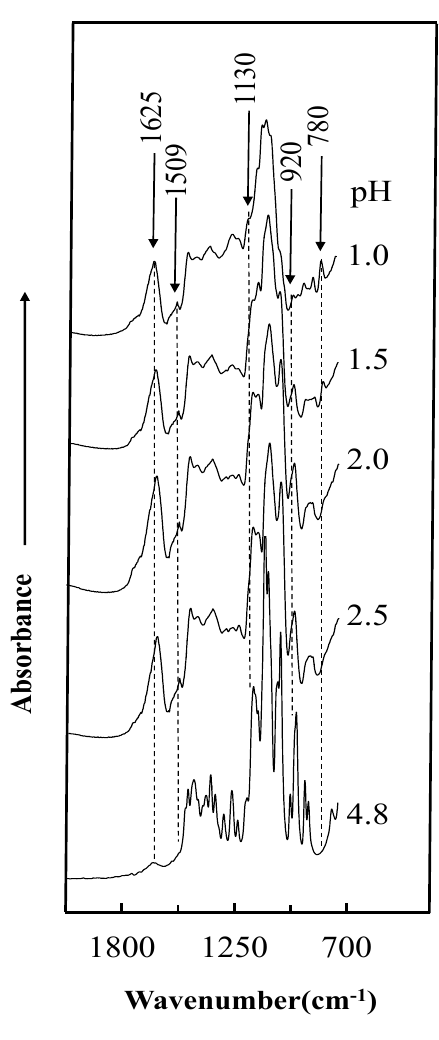
Figure 4. FT-IR spectra of uncured adhesives.